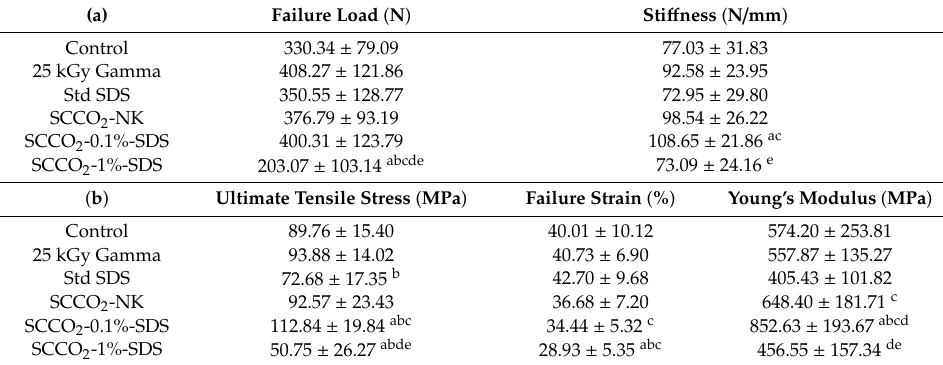
Table 2. The mean values of mechanical properties (failure load and sti ff ness) (a) and material properties (UTS, failure strain, and Young’s modulus) (b) of all